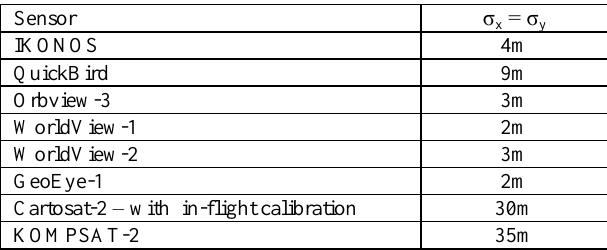
Table 4. Announced standard deviation of scene orientation not Figure 13. IKONOS: upper left: original RGB-image as grey value image; upper right. Panchromatic image; lower left: NIR- image; lower right: Original RGB-image